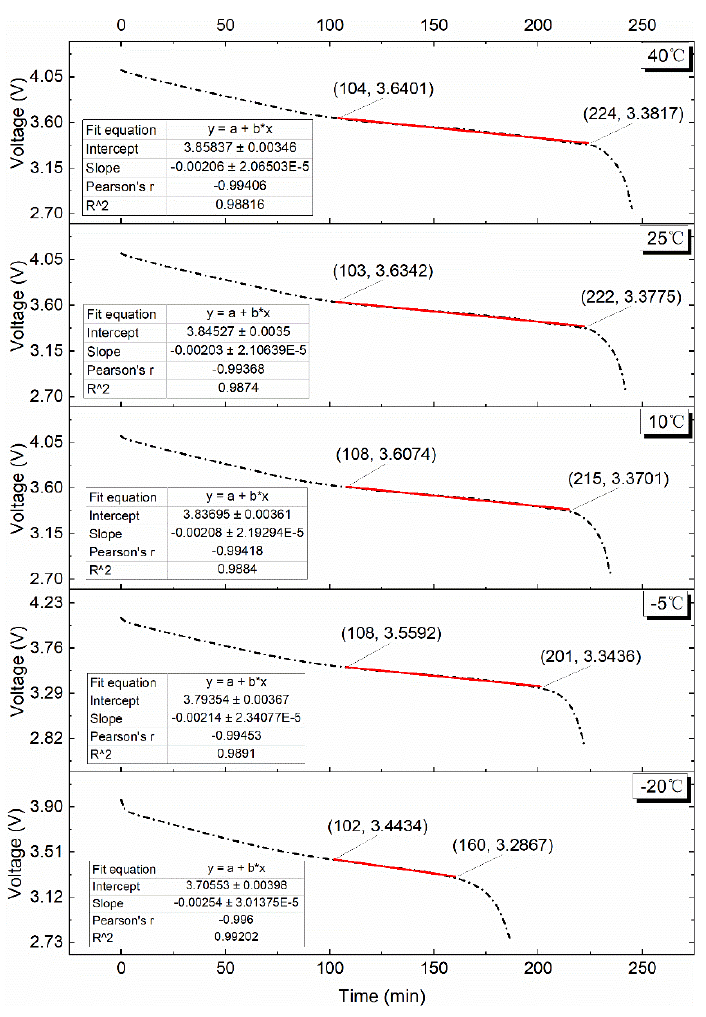
Figure 9. Influence rule of different ambient temperatures on voltage plateau period during 0.25C discharge.